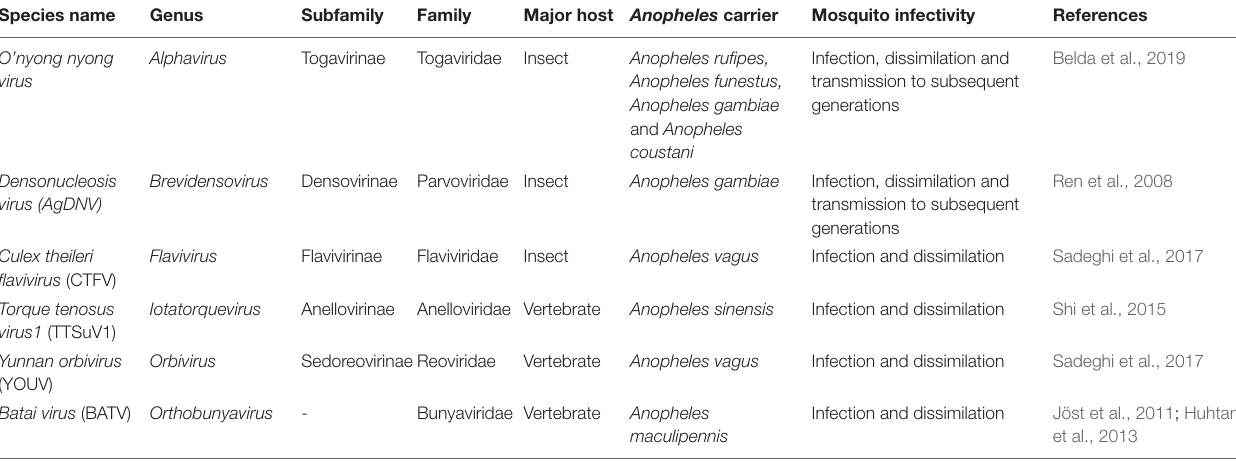
TABLE 1 | Viruses capable of infection, dissemination and transmission in Anopheles